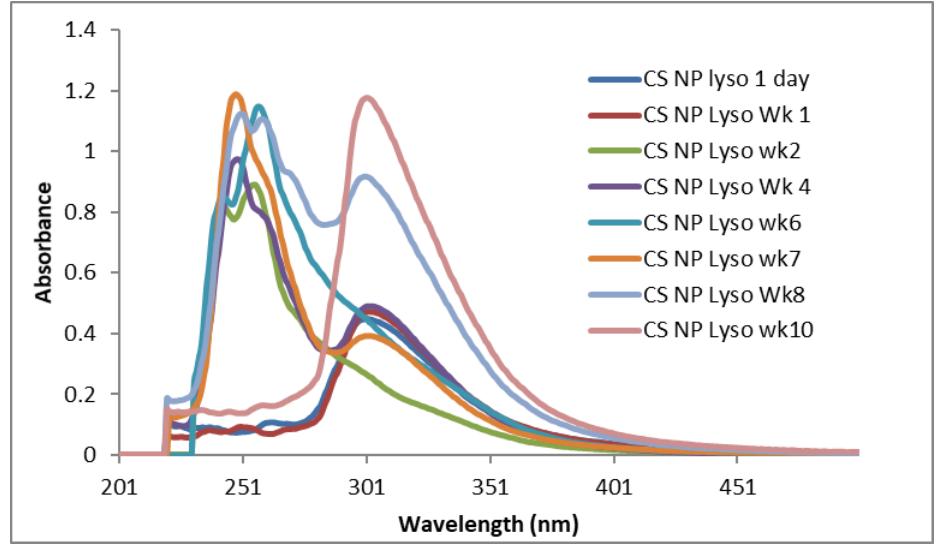
Figure 10. UV- Vis spectra of the supernatant of CS NPs incubated in 0.2% lysozyme solution at 37 °C.